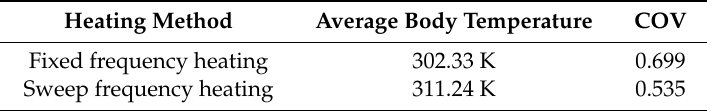
Figure 9. The electric field distribution at different frequencies. 3.4. Simulation Model Applicability Verification Material with different dielectric coefficients was used for simulation verification under the above conditions. Pears and potatoes have different dielectric loss tangent, so pears are selected for simulation and experimentation. The simulation input parameters of pear are shown in Table 3 [29], the simulation results are shown in Table 4, and the experimental results are compared, as shown in Figure 10.